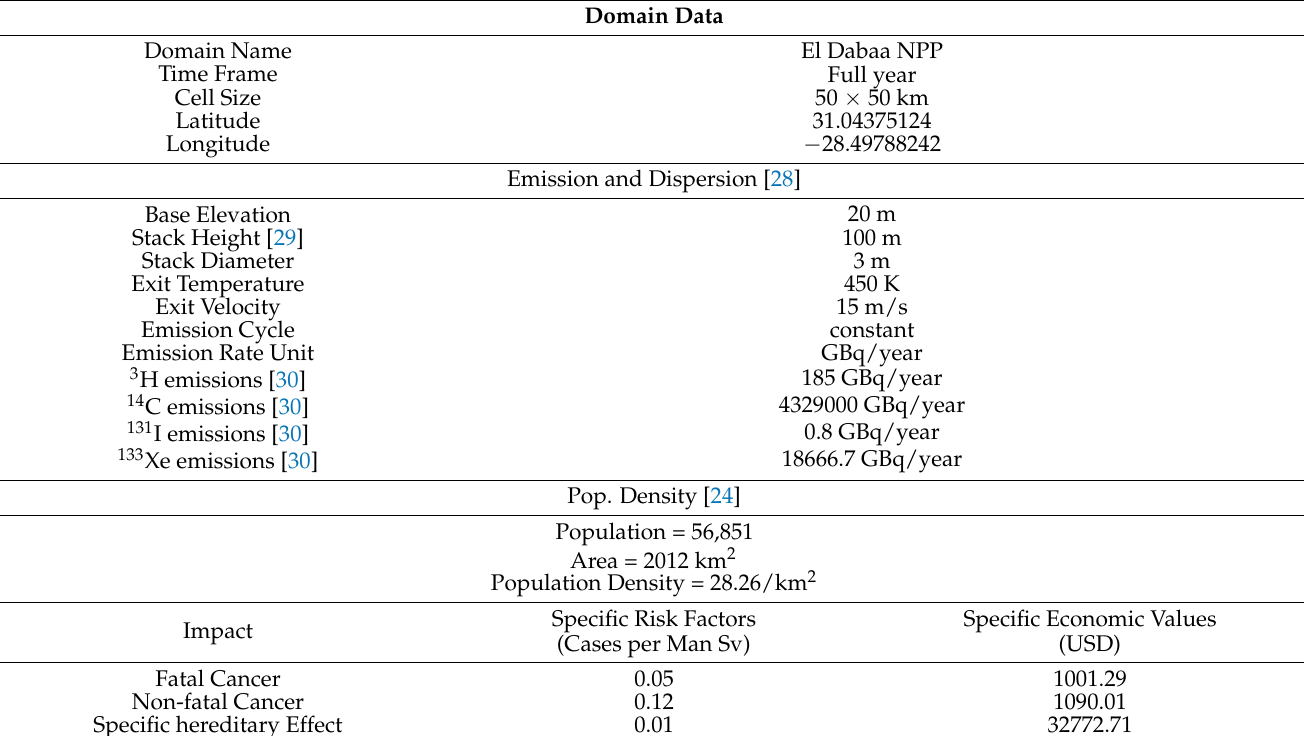
Table 5. Summary of data required to evaluate the environmental effects and associated health-damage costs due to radionuclide emission from a nuclear power